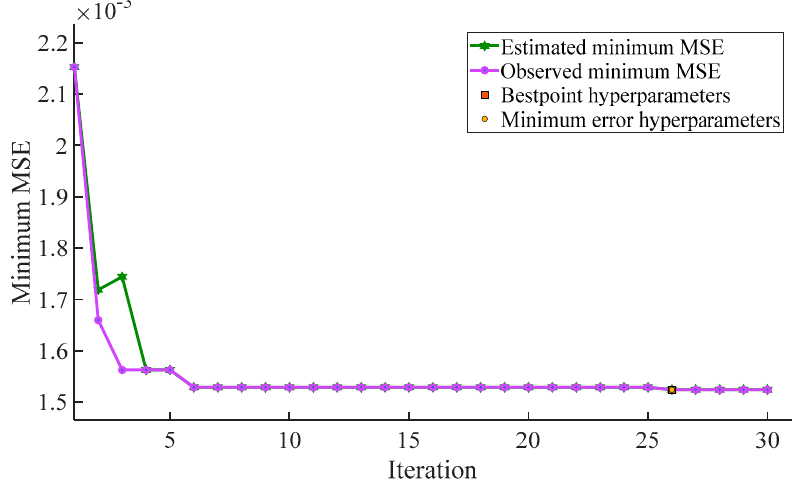
Figure 5. Optimized GPR.